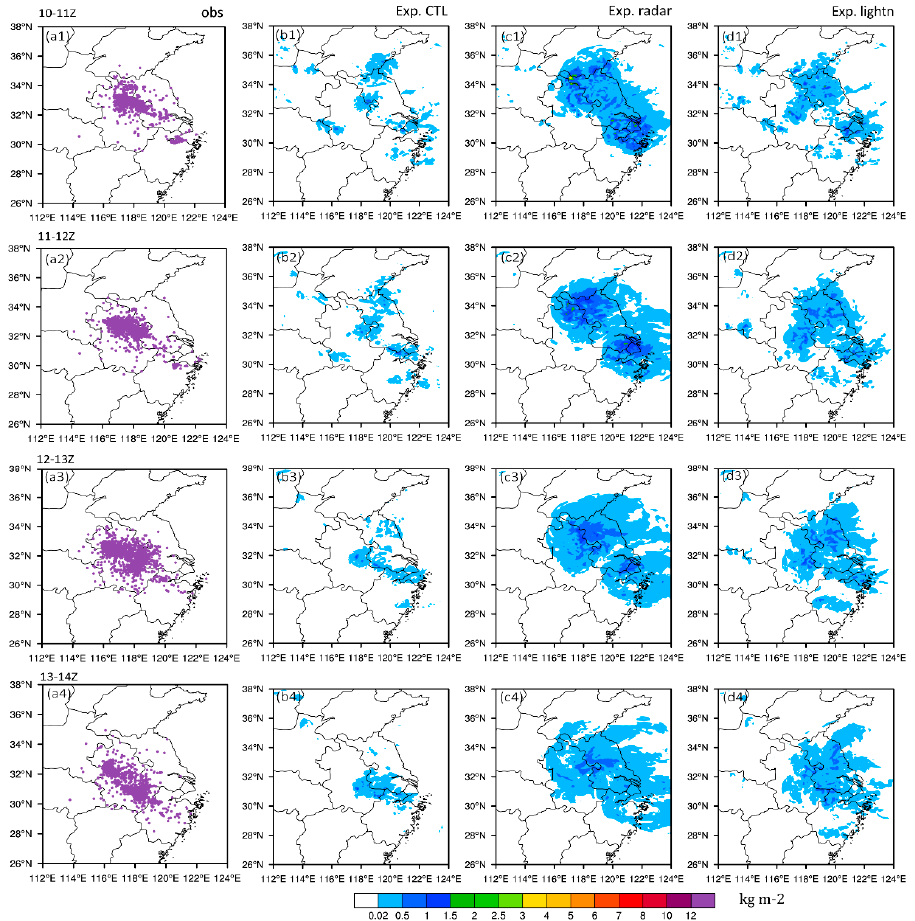
Figure 7. The observed cloud-to-ground lightning location ( a ) and the diagnosed lightning threat index (the integration of ice particles in the vertical direction, LTI 02, unit: kg·m − 2 ) of ( b ) Exp. CTL, ( c ) Exp. radar and ( d ) Exp. lightn hourly from 1000 to 1400 UTC. Row 1 to 4 represents different time interval from 1000 to 1400 UTC.